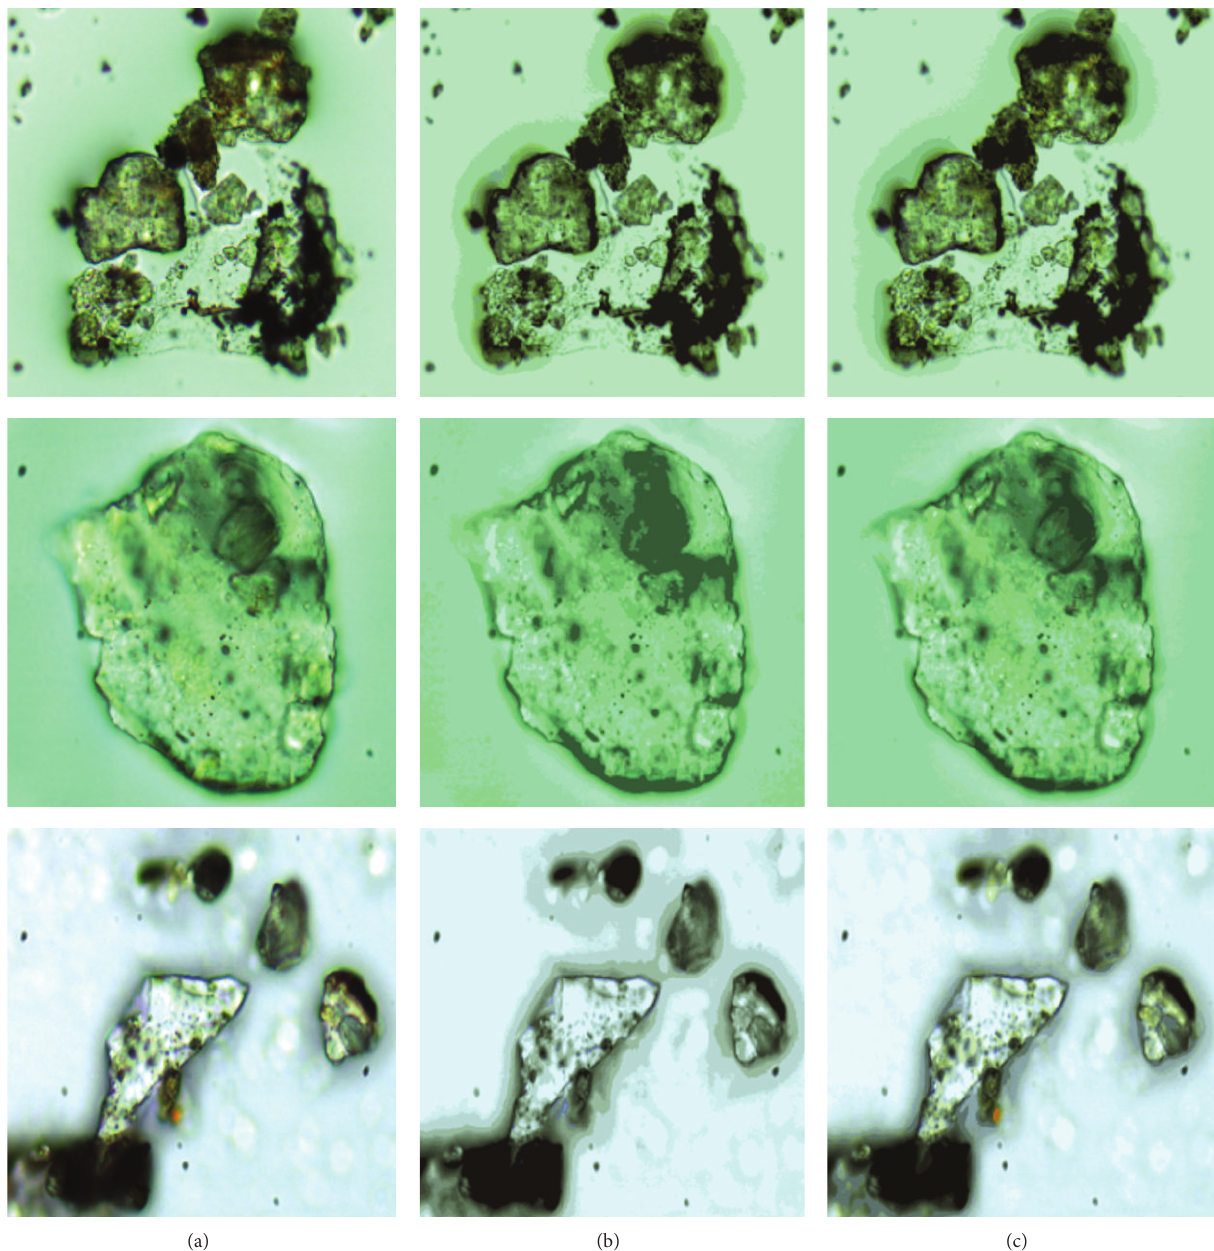
Figure 4: The quantized wear particles’